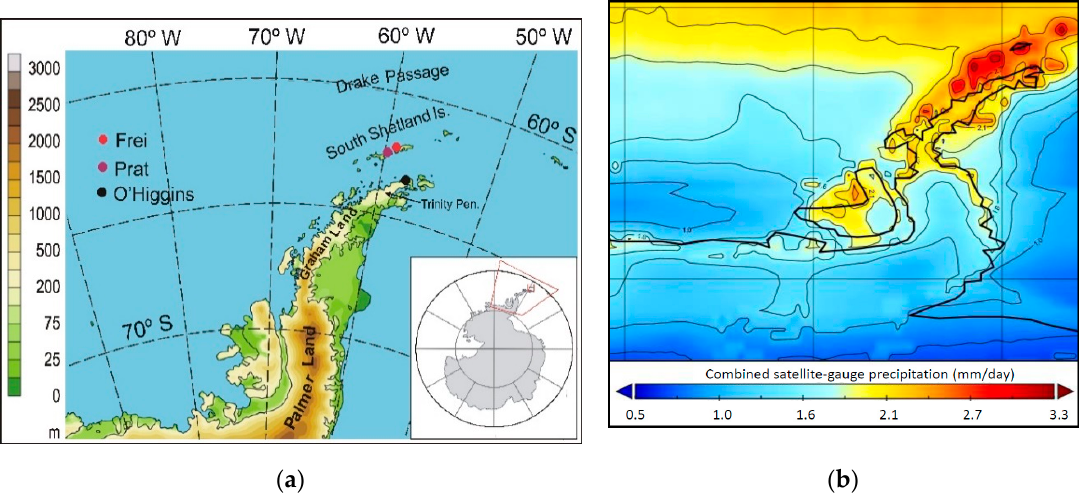
Figure 1. ( a ): Location map of the Antarctic Peninsula and ( b ): averaged map (1991–2010) of combined satellite-gauge precipitation (AIRS, SSMI GPCPMON v3.0) constructed from Giovanni webpage https://giovanni.gsfc.nasa.gov/.